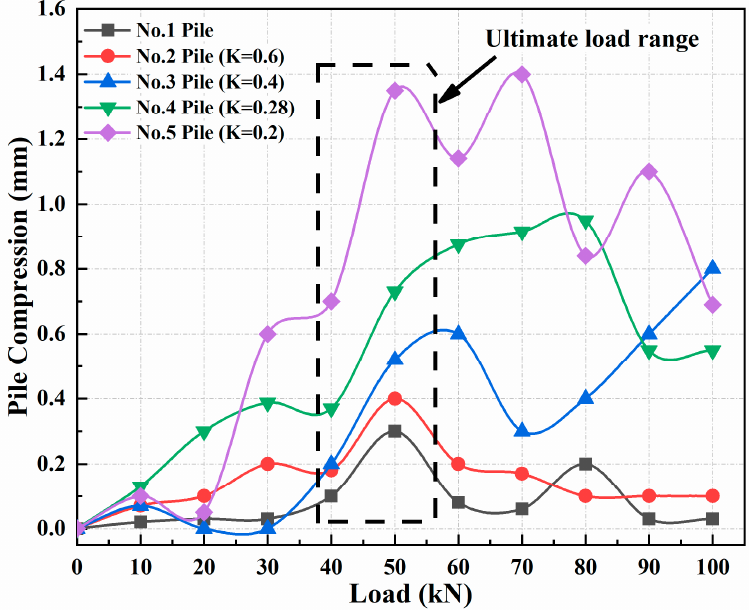
Figure 9. Pile compression curve.